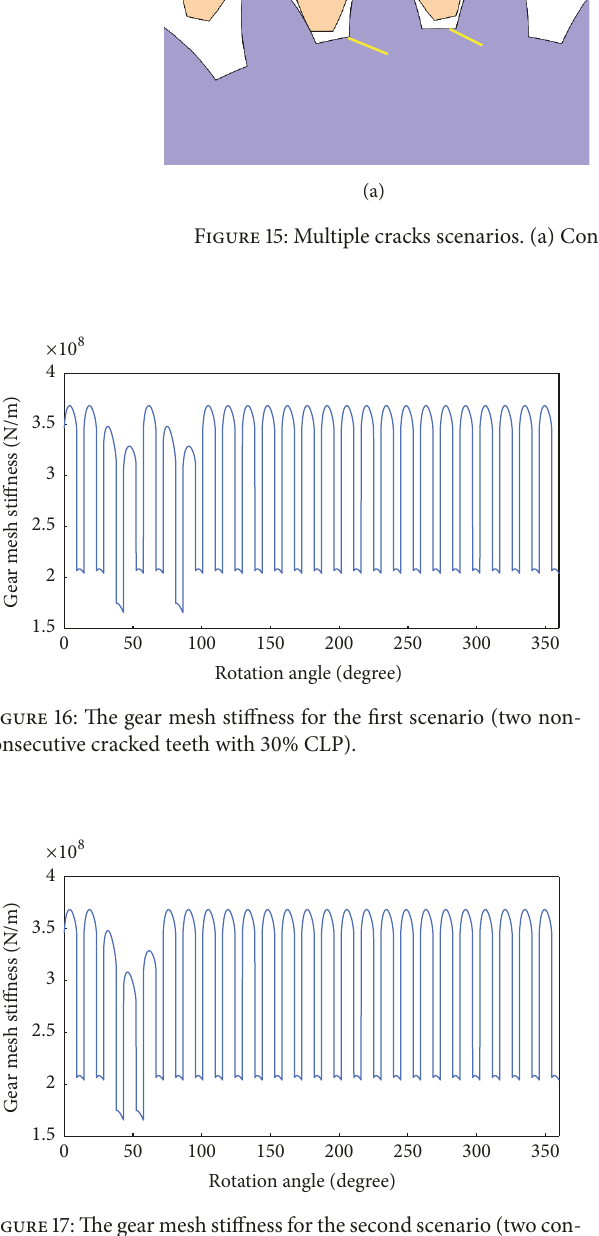
Figure 19: The gear mesh stiffness for the fourth scenario (four con- secutive cracked teeth with CLPs of 20%, 15%, 10%, and